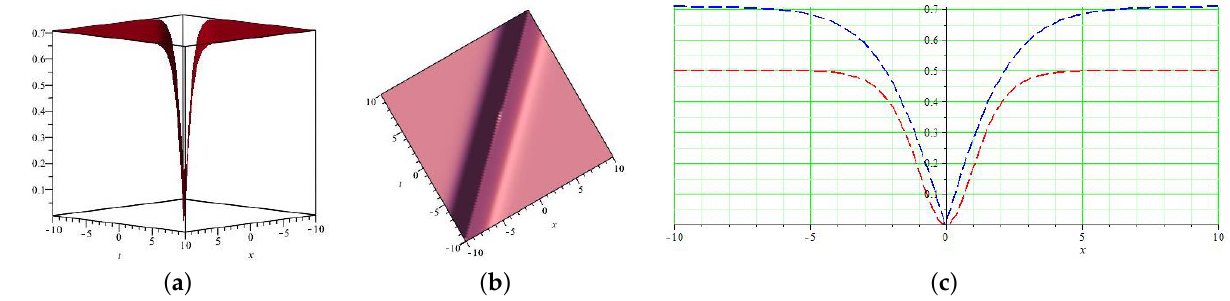
Figure 3. Graph of Z 5 . ( a ) 3D plot. ( b ) Contour plot. ( c ) 2D plot.